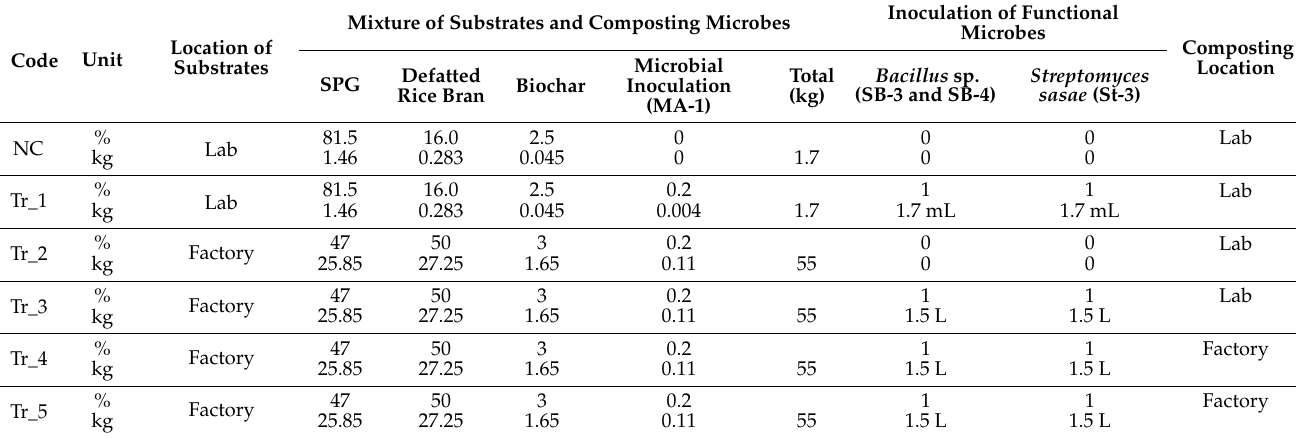
Table 1. Recipes for substrate and microbial inoculum used for composting on the laboratory and pilot scales.